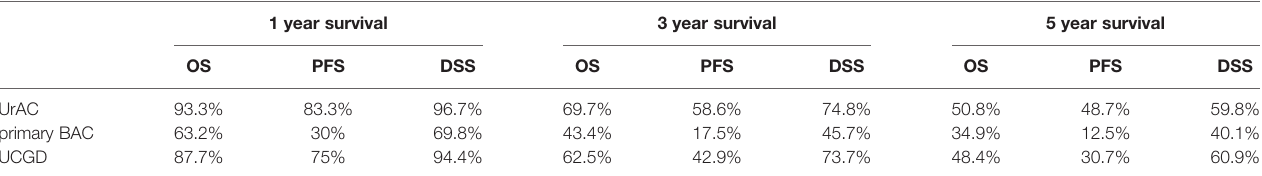
TABLE 2 | Survival comparison of the three groups.